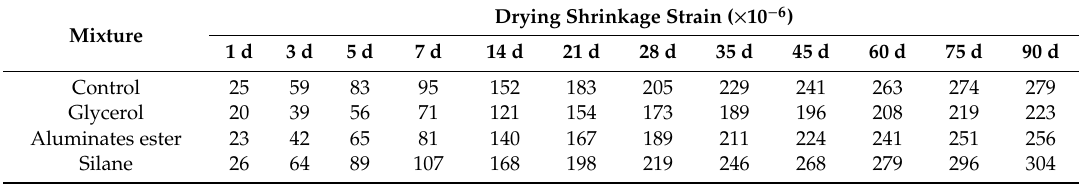
Figure 6. Drying shrinkage of di ff erent mixtures. Table 4. Tabulated shrinkage strain of di ff erent